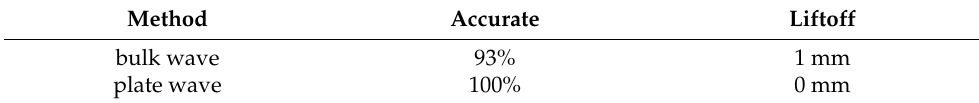
Table 3. The comparation of proposed